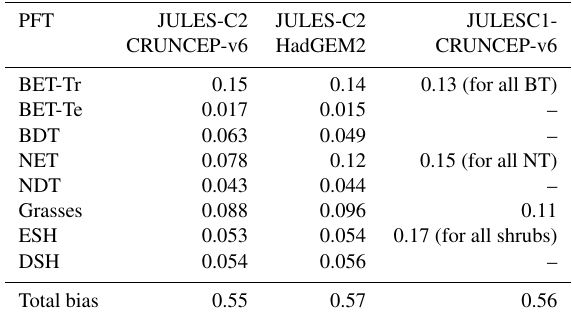
Table 4. Bias in PFT distribution for JULES-C2 run with two dif- ferent climates and JULES-C1 run with the CRUNCEP-v6